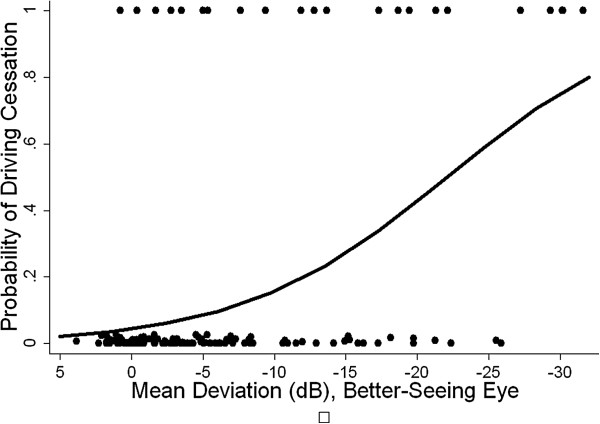
Modeled probability of not driving as a function of better-eye visual field loss in glaucoma patients. In addition to better-eye mean deviation, our multivariable logistic regression model includes age, gender, unemployment, cognition, comorbidities, and depressive symptoms. dB = decibels.